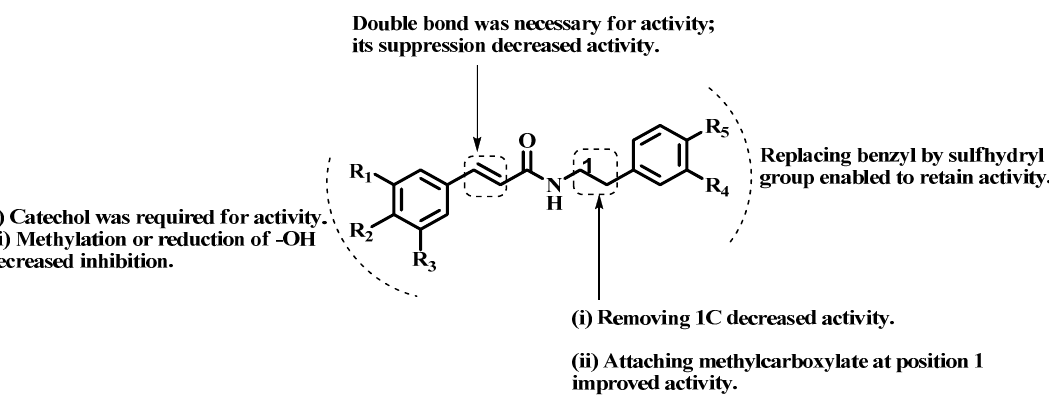
Figure 2. Structure–activity relationships for cinnamide derivatives on b-ARG I.